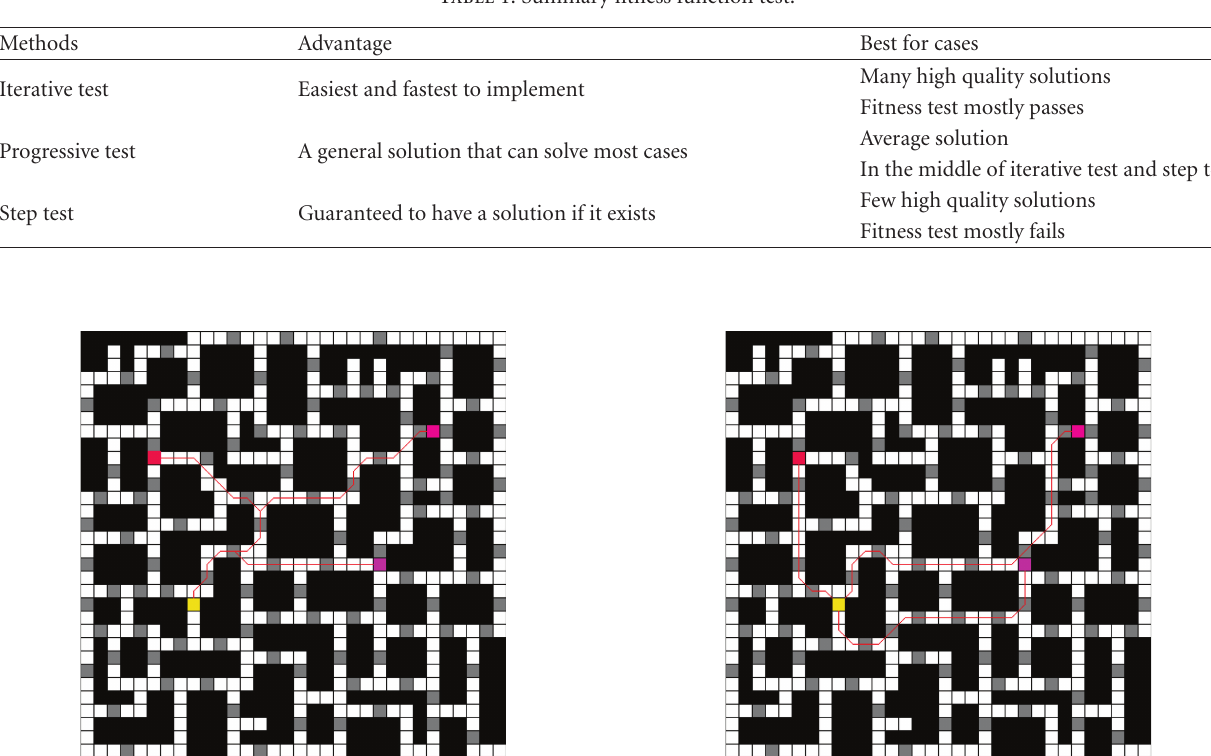
Table 1: Summary fitness function test.